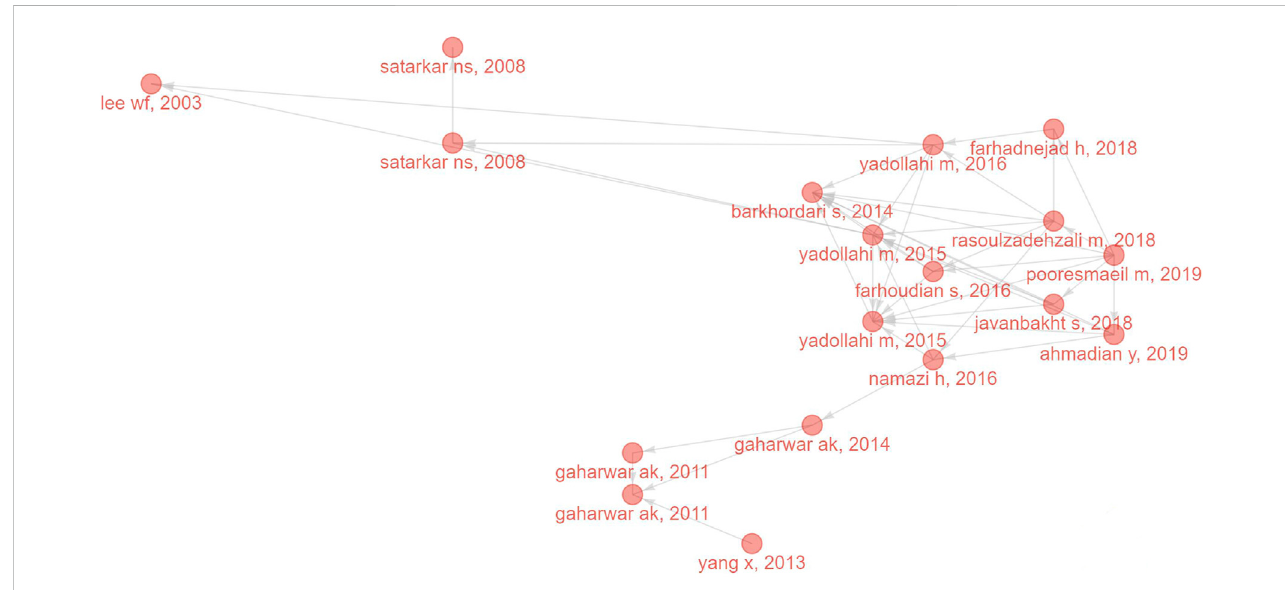
FIGURE 9 Landmark articles related to the applications of NHs for drug delivery.